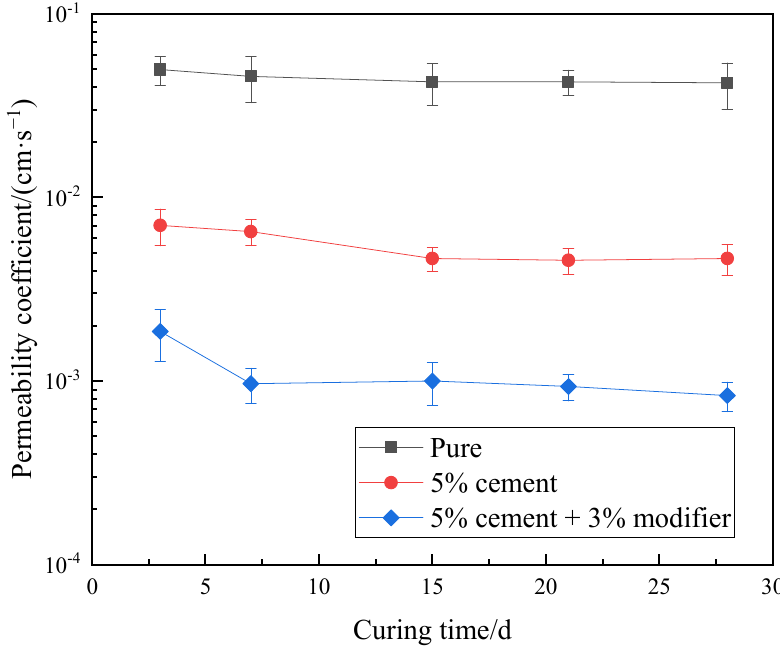
Figure 5. Influence curves of curing time on permeability coefficient.